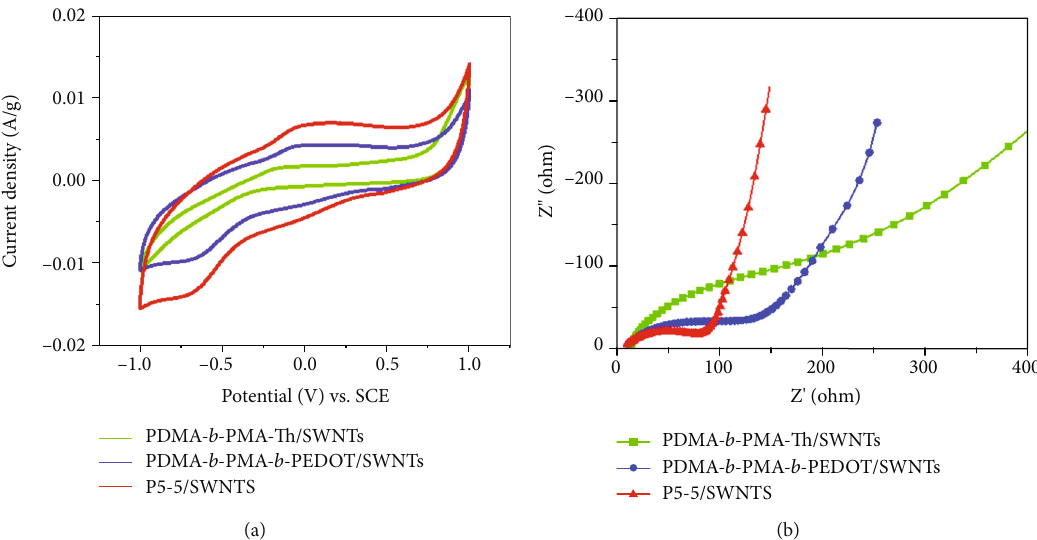
Figure 6: Cyclic voltammograms of the copolymer/SWNT composite at 50mV/s (a) and electrochemical impedance spectroscopy of the copolymer/SWNT composite